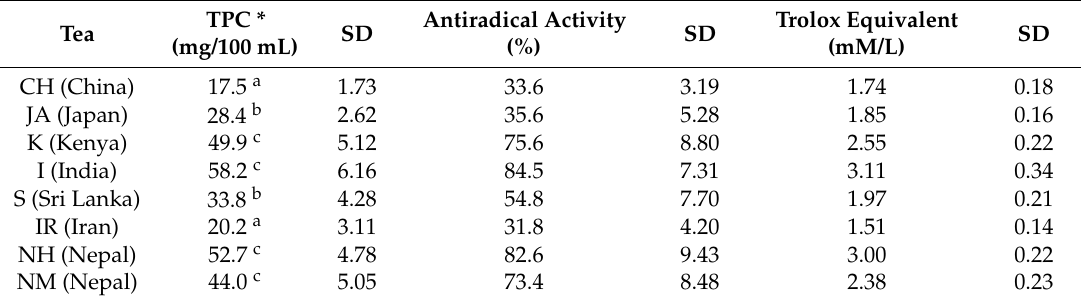
Table 2. Total phenolic content (TPC) and antiradical activity of selected black teas.